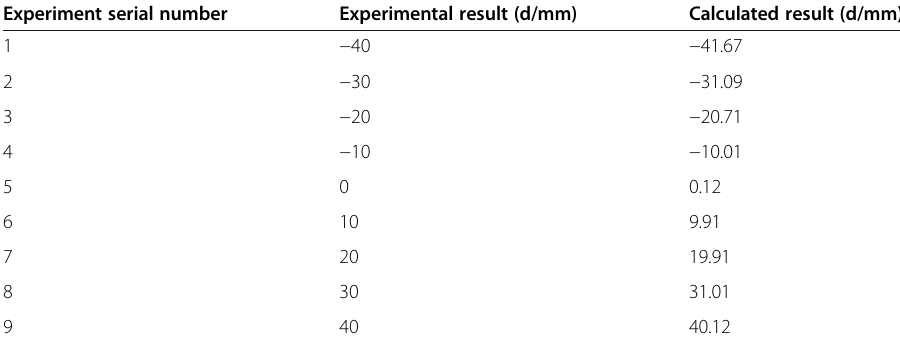
Table 2 Deviation between measured and calculated distance Experiment serial number Experimental result (d/mm)